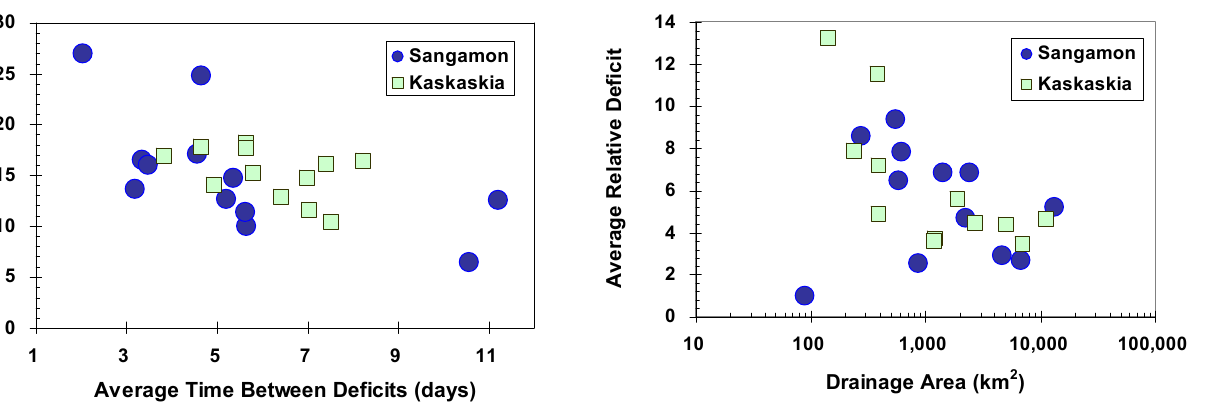
Fig. 12. Average frequency vs. duration of deficit periods from 1990–2011.